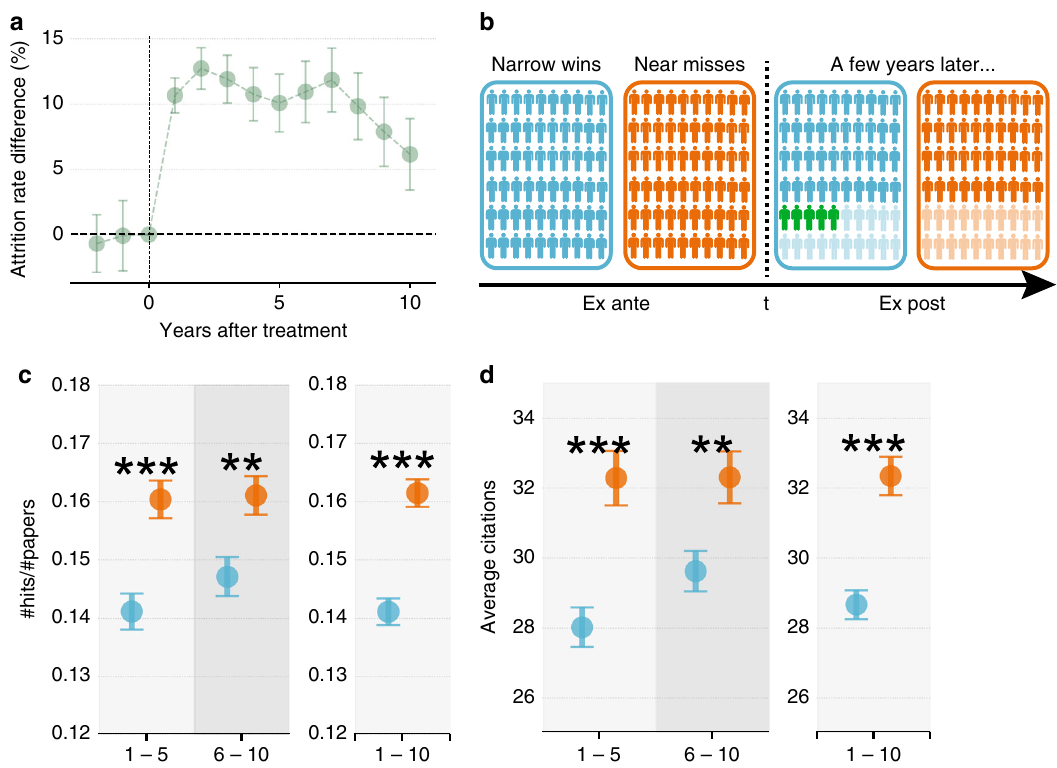
Fig. 3 Testing the screening hypothesis with a conservative removal procedure. a Attrition rate difference between the near-miss and narrow-win group (near misses minus narrow wins). We measure the percentage of PIs remained in each of the two groups, and calculate their difference in each of the ten years after treatment. b An illustration of the conservative removal procedure. To test if the observed performance difference can be accounted for by the population difference, we performed a conservative estimation by removing PIs who published the fewest hit papers but with the most publications from the narrow-win group (blue), such that after removal (green) the two groups have the same fractions of PIs remaining. After removal, the near-miss group still outperformed the narrow-win group in terms of the probability of producing a hit paper ( χ 2 test p -value < 0.001, odds ratio = 1.17) ( c ), or the average citations of papers ( t -test p -value < 0.001, Cohen ’ s d = 0.06) ( d ). The results shown in c – d suggest that while the performance of narrow wins indeed improved following the conservative removal procedure, the screening hypothesis alone cannot account for the uncovered performance gap. *** p < 0.001, ** p < 0.05, * p < 0.1; Error bars represent the standard error of the